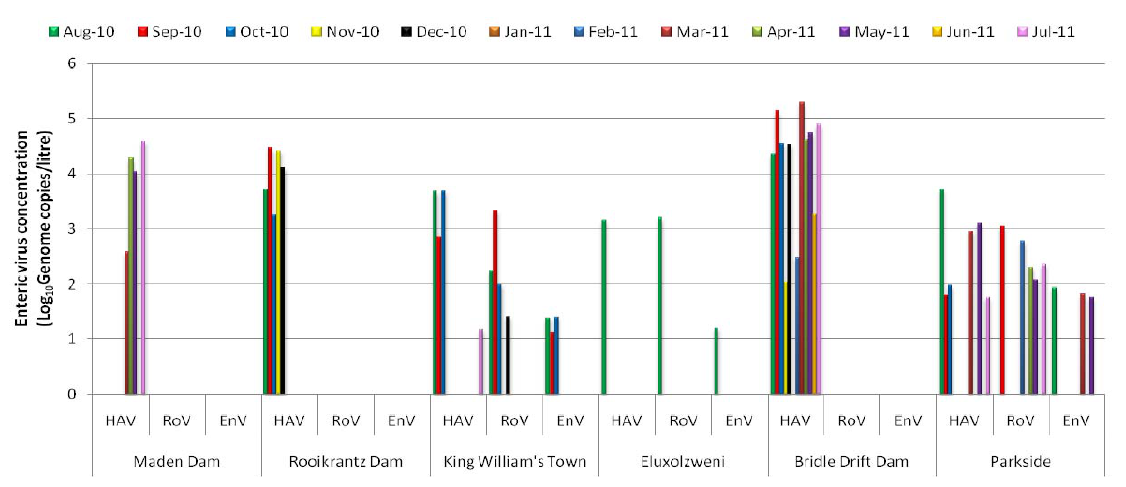
Figure 2. Spatial and monthly variations in concentrations of enteric RNA viruses genome copies/litre) in water samples collected from six sites in the Buffalo (log 10